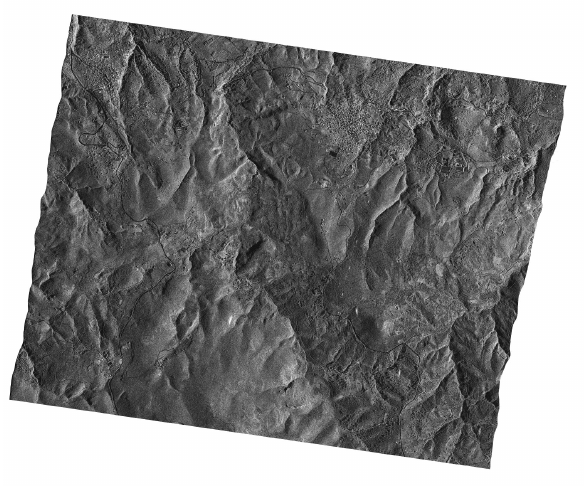
Figure 9: The geometrically corrected image using the ASTER